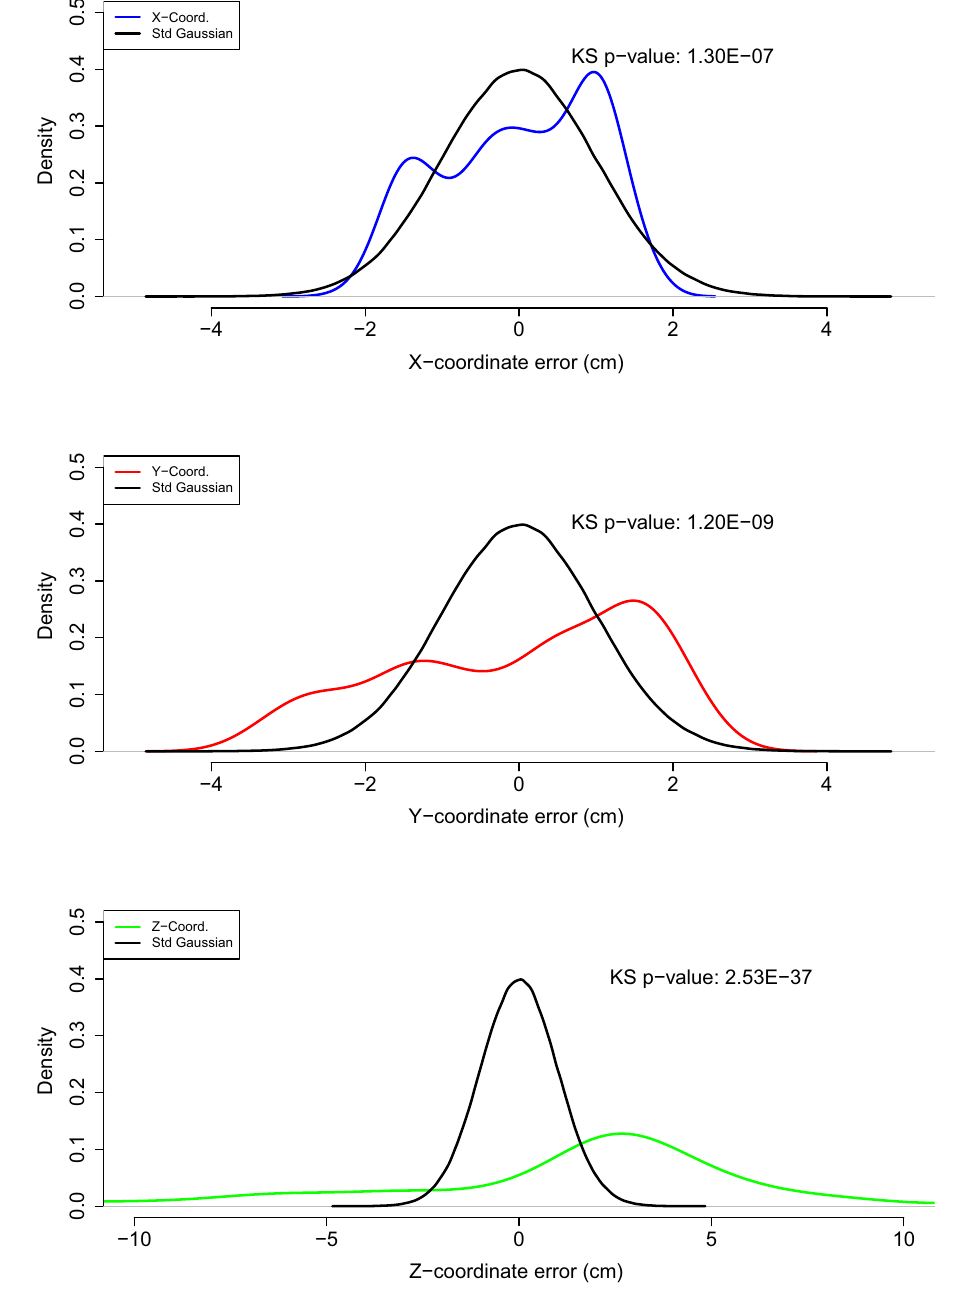
Fig. 14 Distributions of coordinates based on 5 min of disturbed data. Top panel shows the X coord. distribution along with a best fit of a zero- centered Gaussian. Middle and Bottom panel show the same, for the Y and Z coordinates